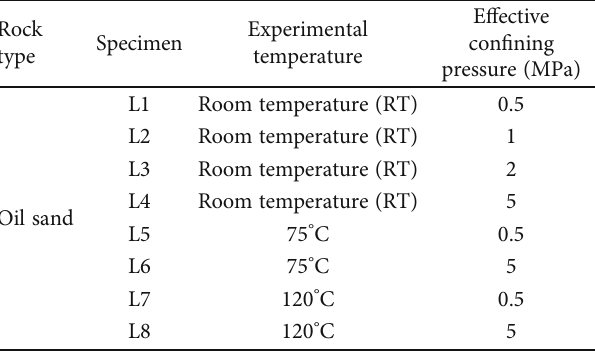
Table 1: Numbering of the oil sand specimens and their corresponding experimental conditions. Rock